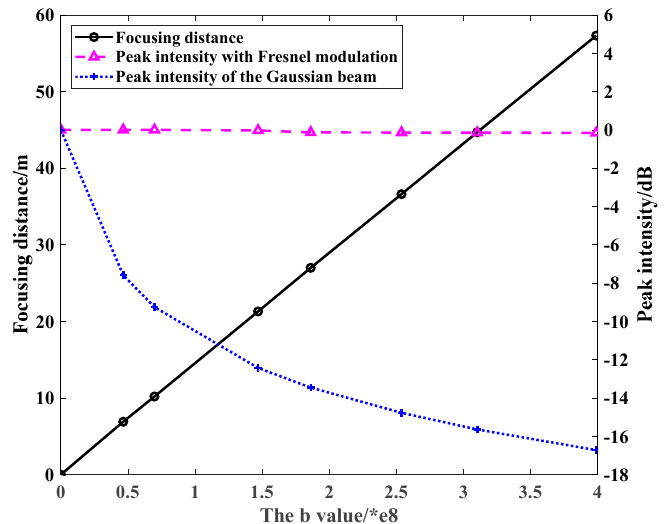
Figure 5. The trend of focusing distance and intensity with b value when loading the Fresnel modulation hologram.